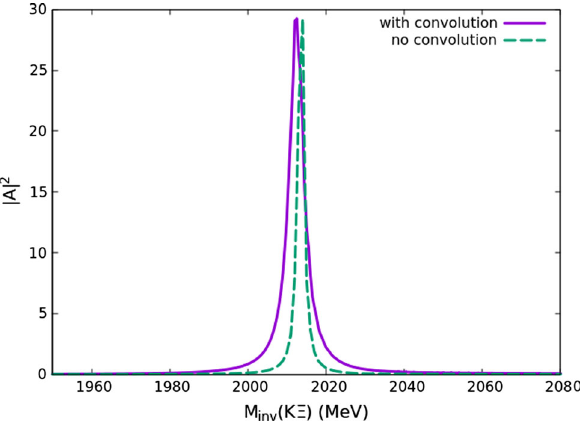
Fig. 7 Plot of | A | 2 calculated using convolution (full line) and by not using the convolution (dashed line) normalized to the